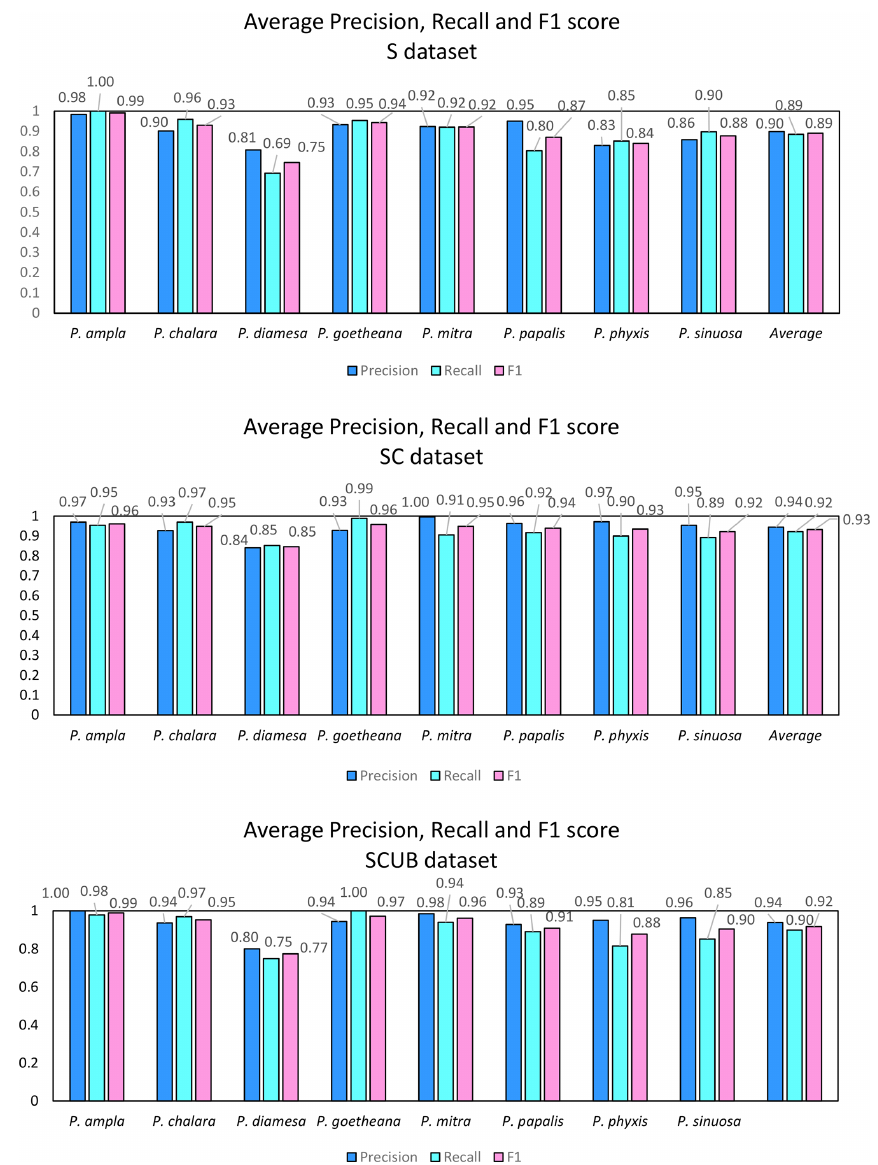
Figure 6. Average precision, recall and F1 score calculated from the average confusion matrices based on the S, SC and SCUB